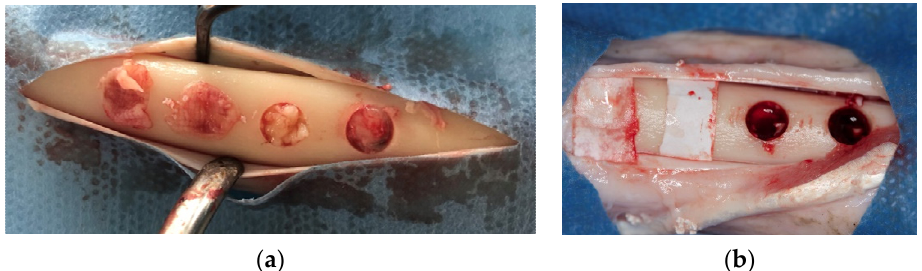
Figure 2. Defects in test and control groups. ( a ): test group; ( b ): control group.